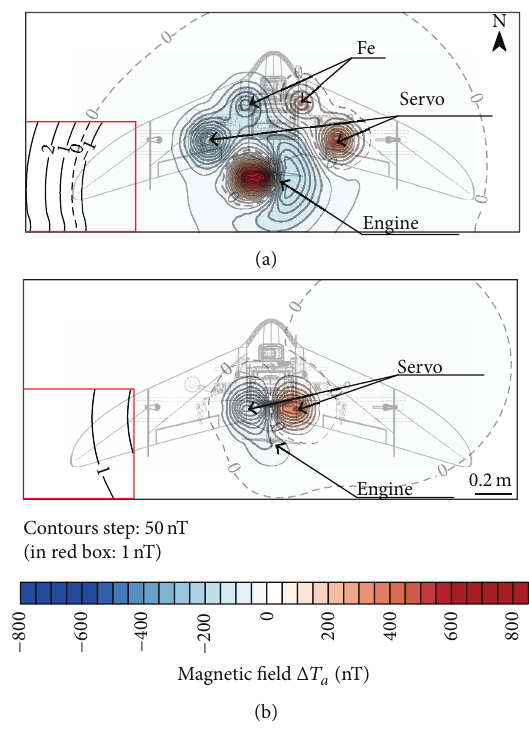
Figure 7: Modeled magnetic field: (a) UAV; (b)